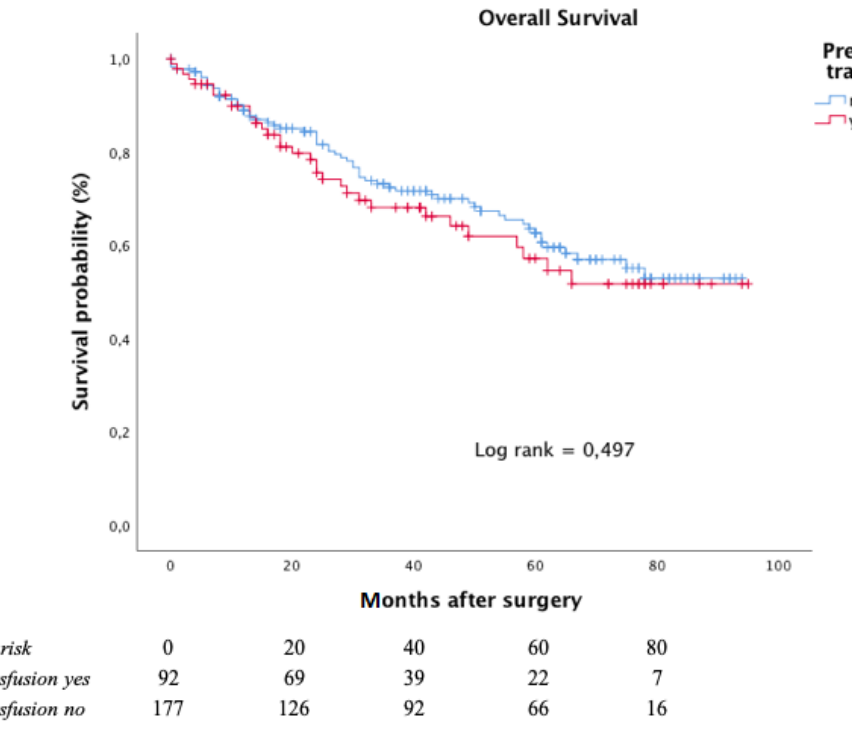
Figure 3. Overall survival according to preoperative transfusion in moderate to severe anaemic patients. After a median follow-up of 38 months (interquartile range: 15–64 months), the five-year OS rate was 62.6% in the subgroup of patients who had not undergone any preoperative transfusions and 57.1% in those who had undergone at least one preoperative blood transfusion.